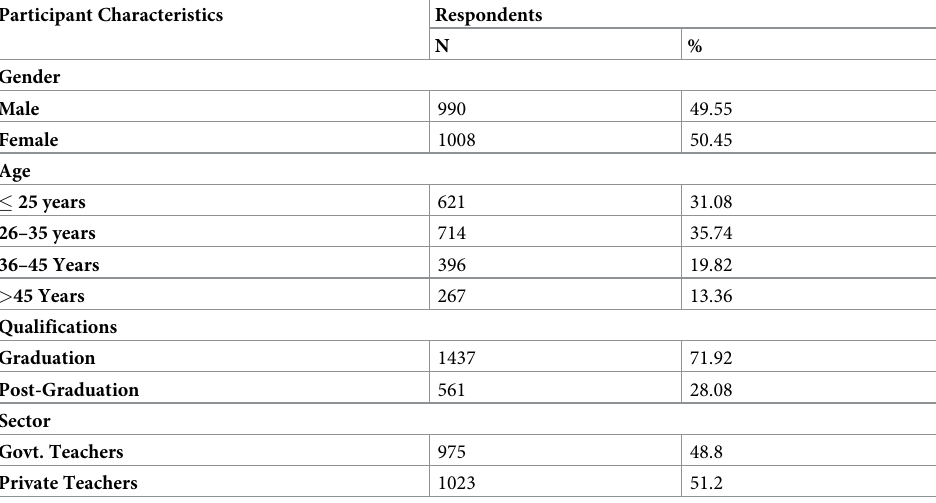
Table 1. Demographic characteristics of the